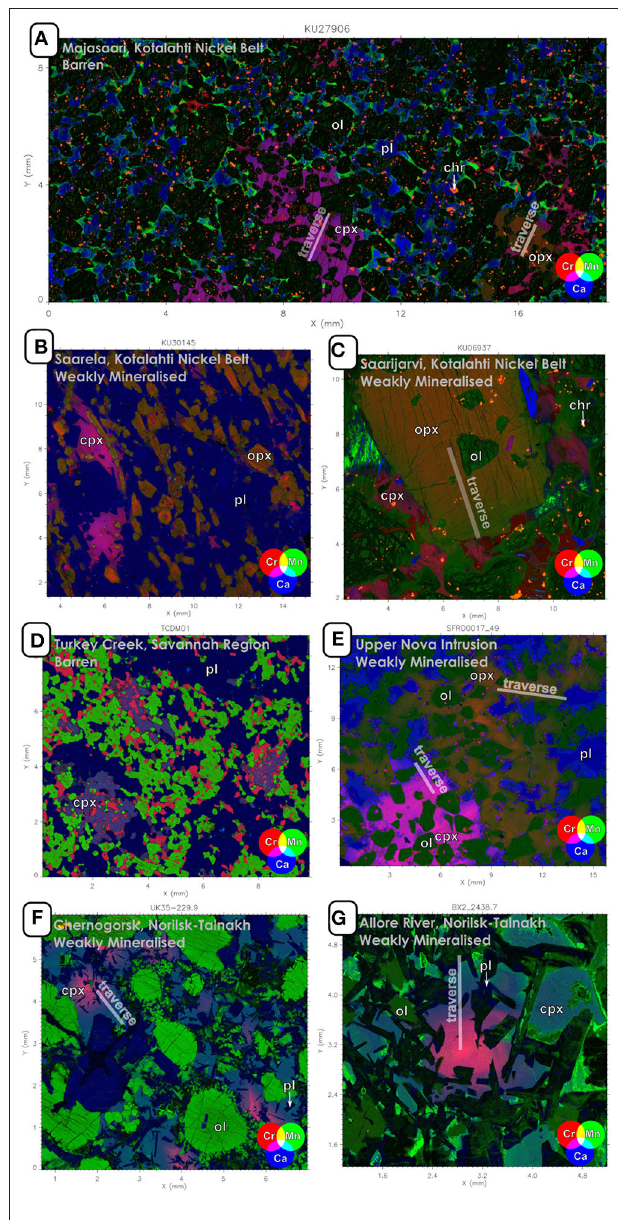
FIGURE 7 | Concentric normal zonation (Cr-rich core, Cr-poor rim) in pyroxene from reactions with the trapped liquid during crystallization. Note lack of abrupt step between cores and rims. X-ray Fluorescence (XRF) images collected from the Australian Synchrotron using low energy (7,050eV) method (Barnes et al., 2020) Stacked false color (RGB) image of chromium concentration in red, manganese in green and calcium in blue. Mineral abbreviations: cpx, clinopyroxene; ol, olivine; opx, orthopyroxene; pl,